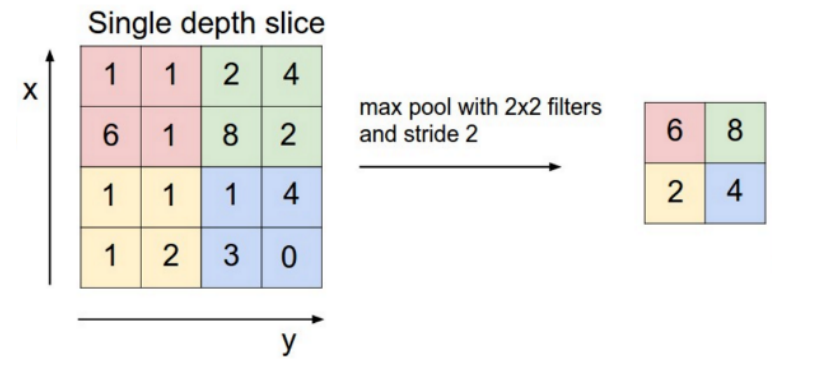
Figure 15. The pooling process.